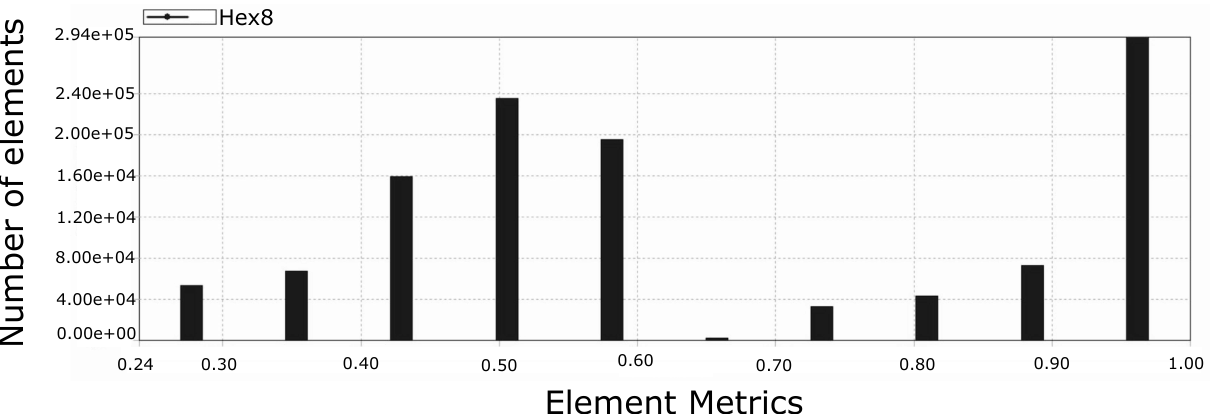
Figure 11. Mesh quality report of rectal lumen model, where 0 is poor element quality and 1 is perfect element quality. The predominance of elements with a metric of 1 contributed to the success of the simulation and generated confidence in the results obtained. Note: Hex8 is the type of element used by the mesh and represents a hexahedron with 8